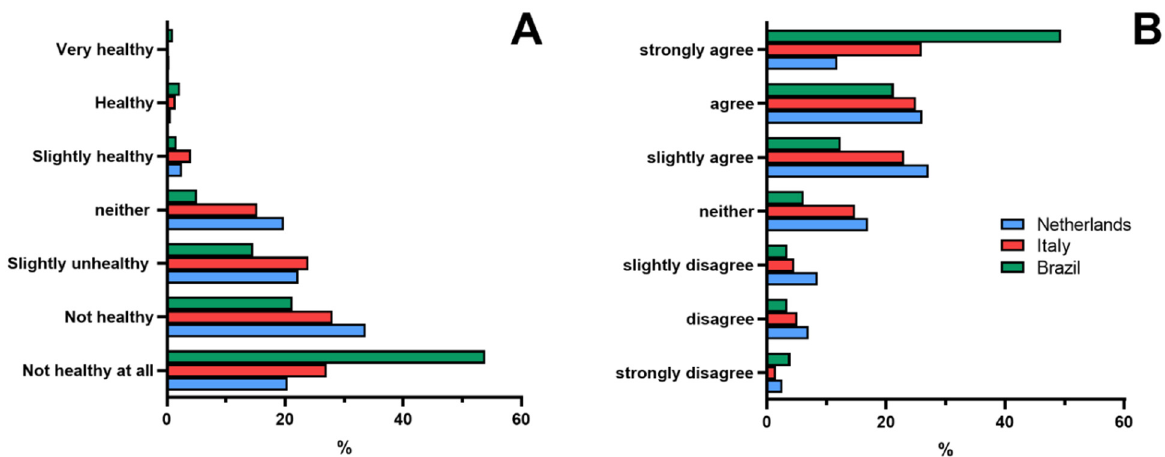
Figure 4. Healthiness perception of UPFs of Dutch ( n = 277), Italian ( n = 204), and Brazilian ( n = 181) consumers ( A ). Agreement with the statement that UPF contributes to weight gain ( B ).